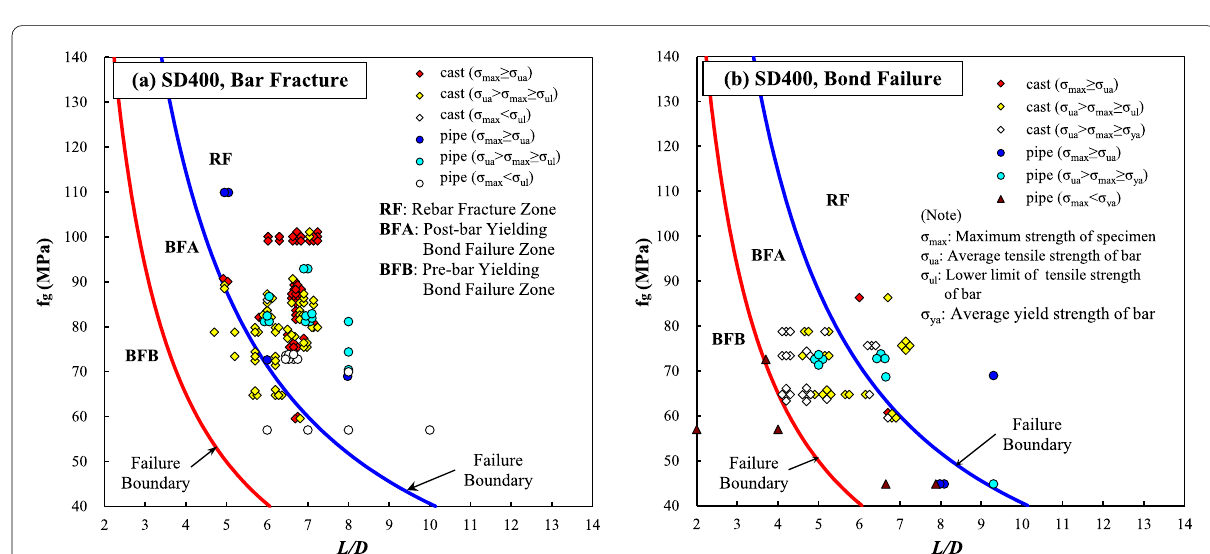
Fig. 3 Failure mode estimation based on Hayashi equation. (Test specimens with